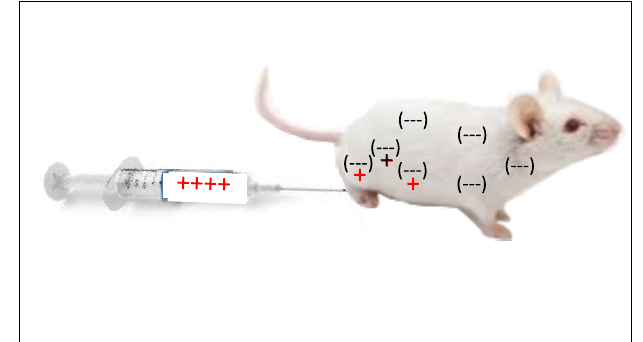
FIGURE 2 | Injection of bovine serum albumin, chemically modified to be “positively charged,” into a mouse caused it to be retained longer at the site of injection, and stimulated a stronger T cell mediated immune response